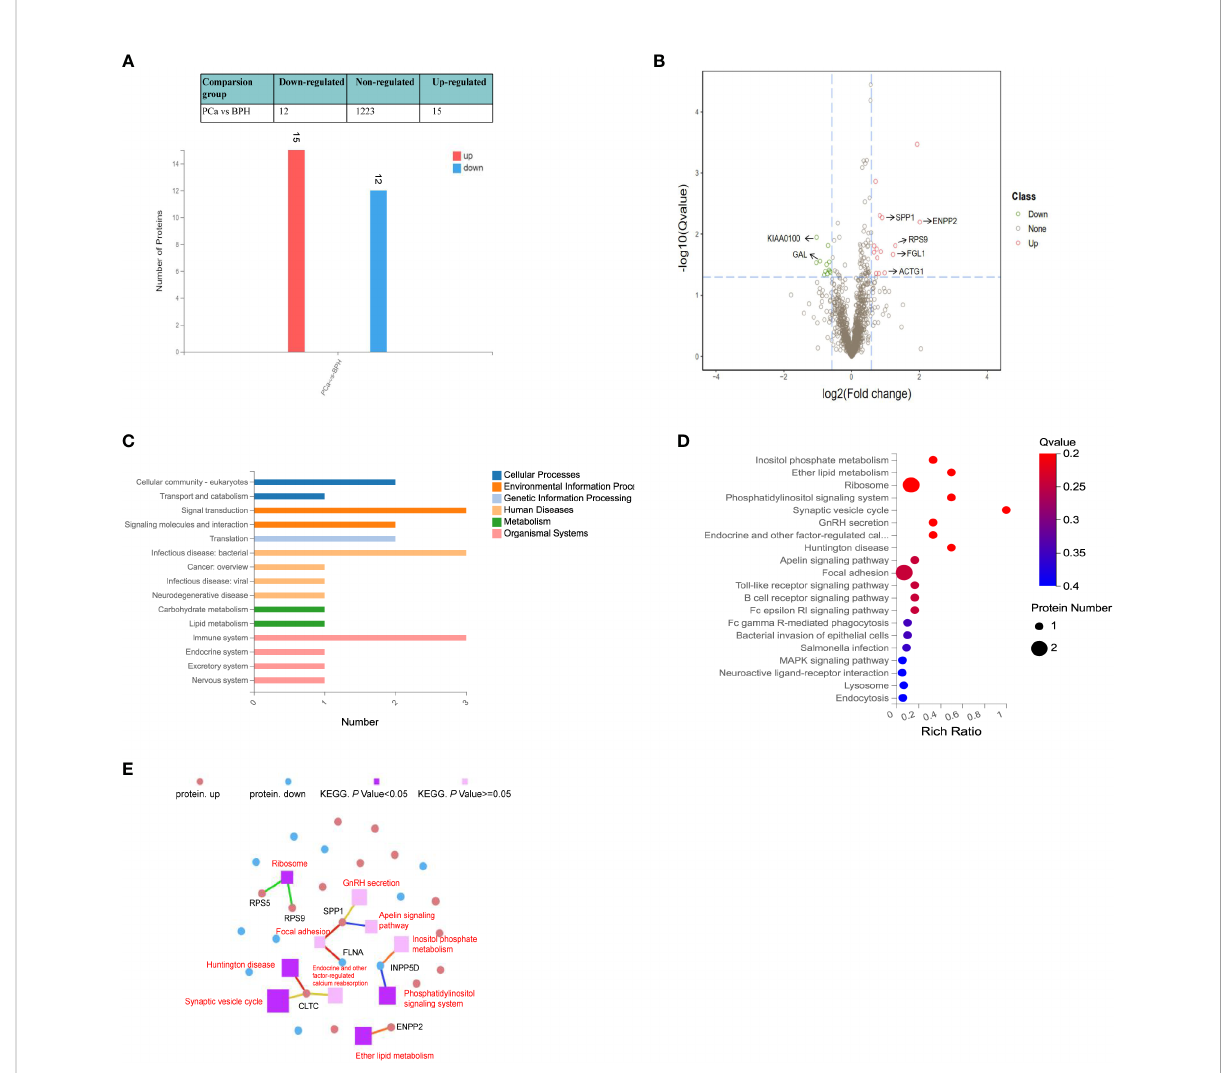
FIGURE 3 Quantitative differential analysis between PCa and BPH patients. (A) Bar chart of DEPs. The X-axis represents comparison group information; Y- axis represents the number of DEP. Red represents the signi fi cantly up-regulated proteins. Blue represents signi fi cantly down-regulated proteins. (B) Volcano map of the DEPs between PCa and BPH patients. Red and green dots represent up- and down-regulated proteins, respectively. (C) KEGG pathway classi fi cation. The X-axis represents the number of proteins annotated to a certain KEGG Pathway category, and the Y-axis represents the KEGG pathway category. (D) KEGG pathway enrichment analysis. The function of Q value < 0.05 was considered a signi fi cant enrichment. (E) KEGG pathway relationship network. The red and blue dots represent up-regulated and down-regulated differential proteins, respectively. The purple spheres represent the pathways of top 10 enrichment, dark color indicates signi fi cant enrichment, light color indicates insigni fi cant enrichment, and the larger the area is, the higher the enrichment degree